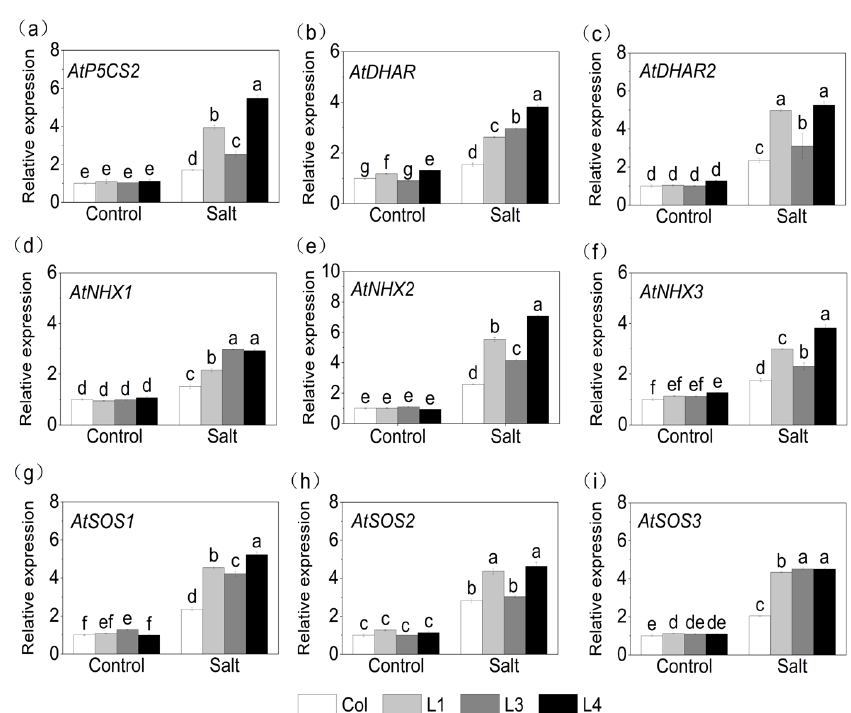
Fig. 8: Expression of drought resistance-related genes in transgenic and wild-type A. thaliana under drought stress.